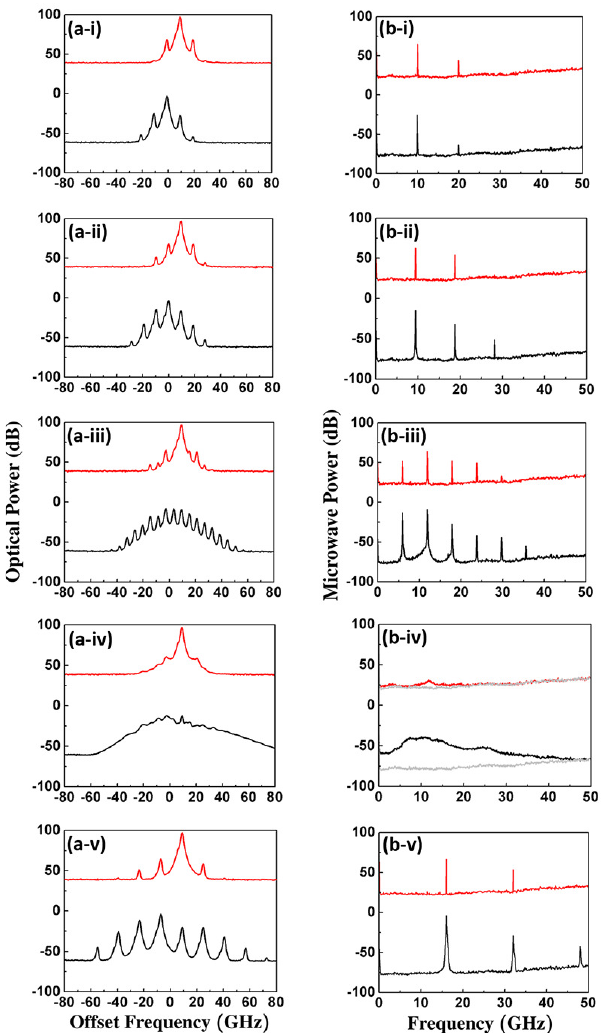
Figure 9. ( a ) Optical spectra and ( b ) microwave spectra of LD1 (red curve) and LD2 (black curve) for ( i ) ξ e = 0.019, ( ii ) ξ e = 0.064, ( iii ) ξ e = 0.151, ( iv ) ξ e = 0.213, and ( v ) ξ e = 0.3, respectively, when 12 12 12 12 12 ξ e = 0.01 and f i = 10 GHz. The x -axes in ( a ) are relative to the free-running oscillation frequency 21 of LD2. The red curves in ( a , b ) are up-shifted by 100 dB for clear visibility. The gray curves in ( b-iv ) show the noise floor of the laser